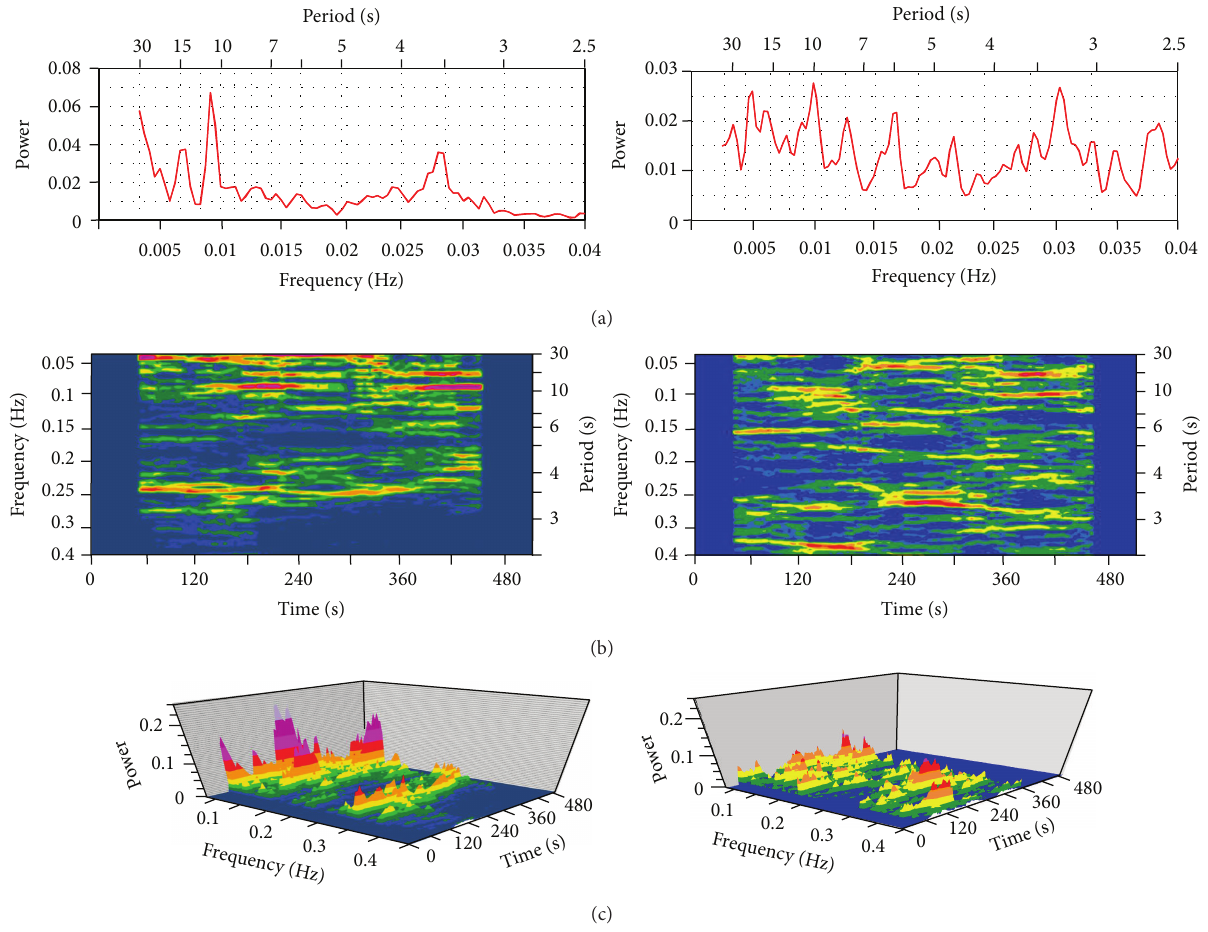
Figure 3: Spectra of electrocardiograms (ECG) in two persons. Left fragment: sinus rhythm in patient B; right one: atrial fibrillation in patient GSK. (a): global spectra of 9 minutes record. Abscissas: spectral components, below: frequency (Hz), and above: period length of oscillations (sec); ordinate: power ( 𝜂 2 ) of spectral components ( 𝜂 2 = ratio of described and general variances). ((b) and (c)); 3D gliding spectra of the same records. and (b): view from above (elevation = 90 ∘ ); (c): view from aside (elevation, rotation, and perspective = 30 ∘ ). Abscissa: time from starting records (sec), ordinate: frequency (Hz), and applicate: spectral power marked by different colors; blue: statistically not significant values, green components significant at 0.05 > 𝑃 > 0.01 , yellow: at 0.01 > 𝑃 > 0.001 , orange: at 0.001 > 𝑃 > 0.0001 , and red: at 0.0001 > 𝑃 >